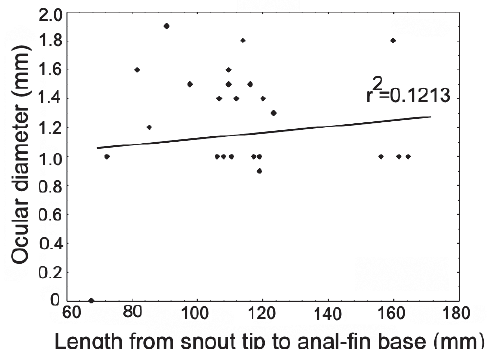
Fig. 4. Regression between OD and LEA in Eigenmannia vicentespelaea (n = 25).